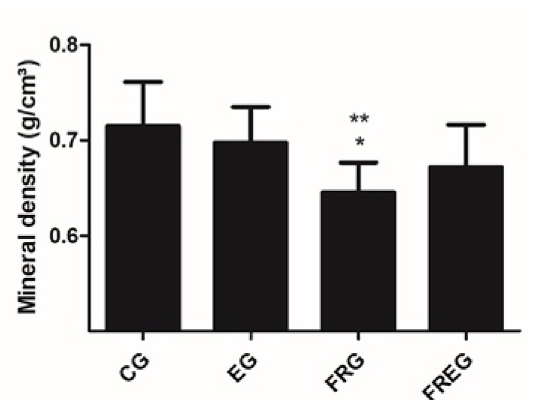
Figure 3 - Data from femoral mineral density in control (CG), exercised (EG), food restriction (FRG), and food restriction/exercised (FREG) from female rats. Values expressed as mean and standard deviation. *p<0.01 in relation to CG (ES = 1.80) and **p=0,02 in relation to EG (ES =